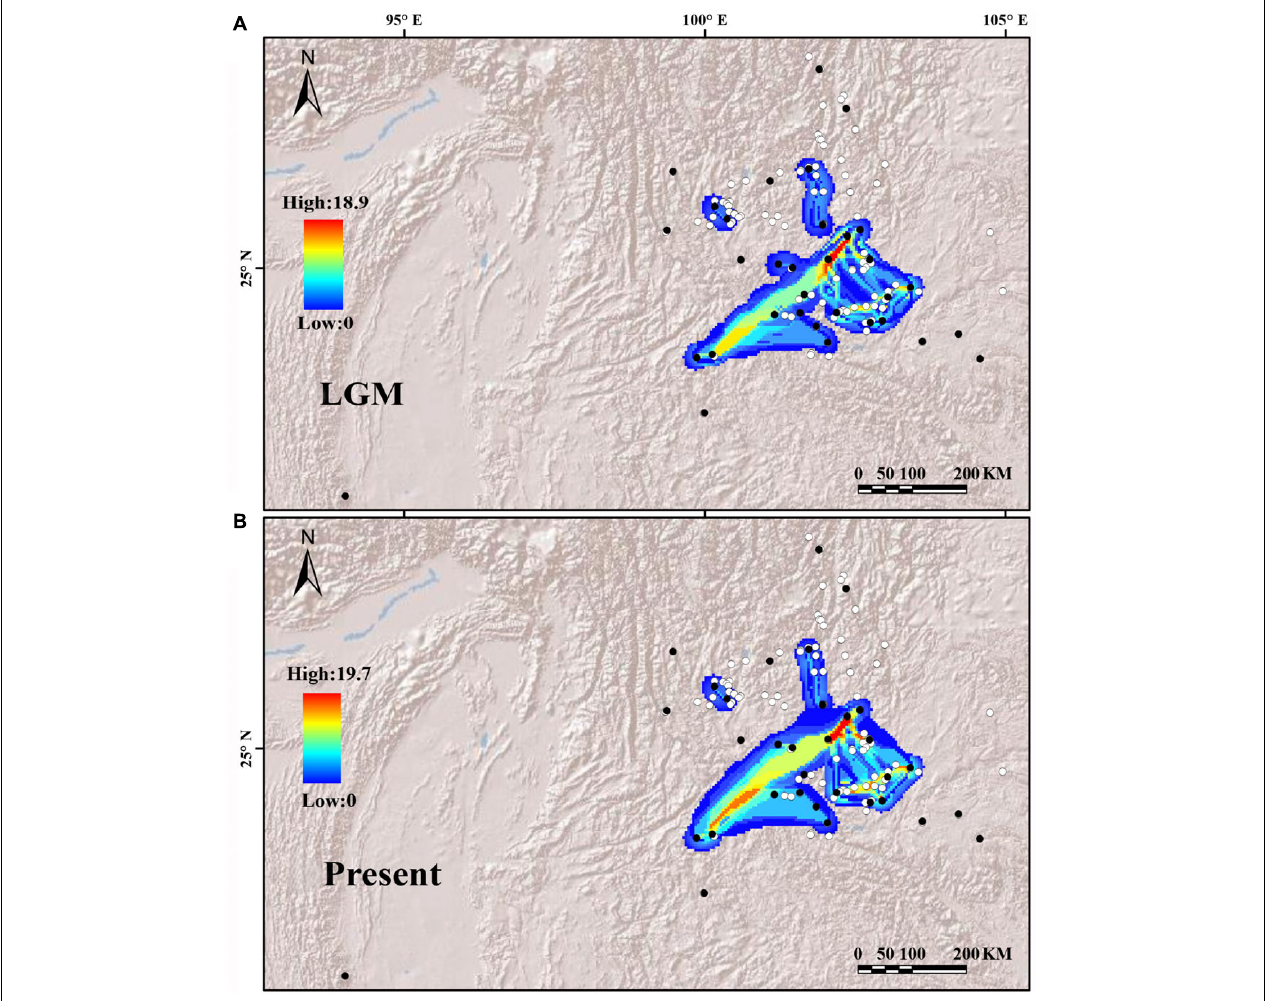
FIGURE 6 | Potential dispersal corridors of the Quercus franchetii complex during (A) the last glacial maximum (LGM) and (B) the present. Both white and black dots are the occurrence points of the Q. franchetii complex, with the black dots indicating sampling sites used in this study and white points indicating occurrence sites obtained from herbarium records. Colors in (A,B) from blue to red represent the potential of species dispersal corridors from low to high. TABLE 3 | Correlation between genetic diversity, habitat and geographical factors of Quercus franchetii complex. A r H e C A